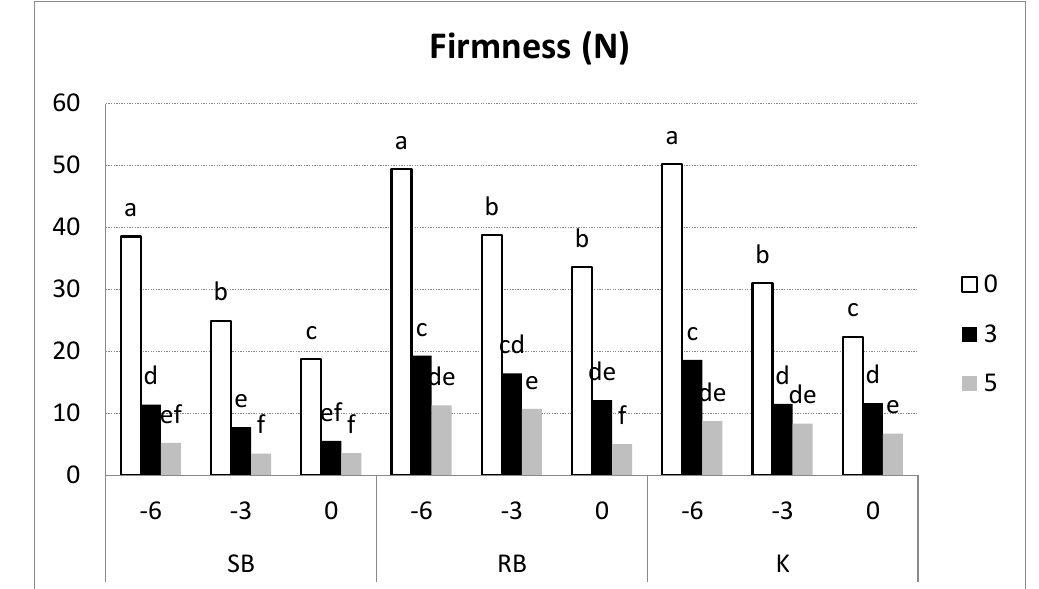
Figure 7. Evolution of firmness by compression of apricot cultivars at all three harvest dates and subsequent shelf-life. Per cultivar, samples with different letters differ at a significance level of 0.05 according to the Tukey Test (n = 20).